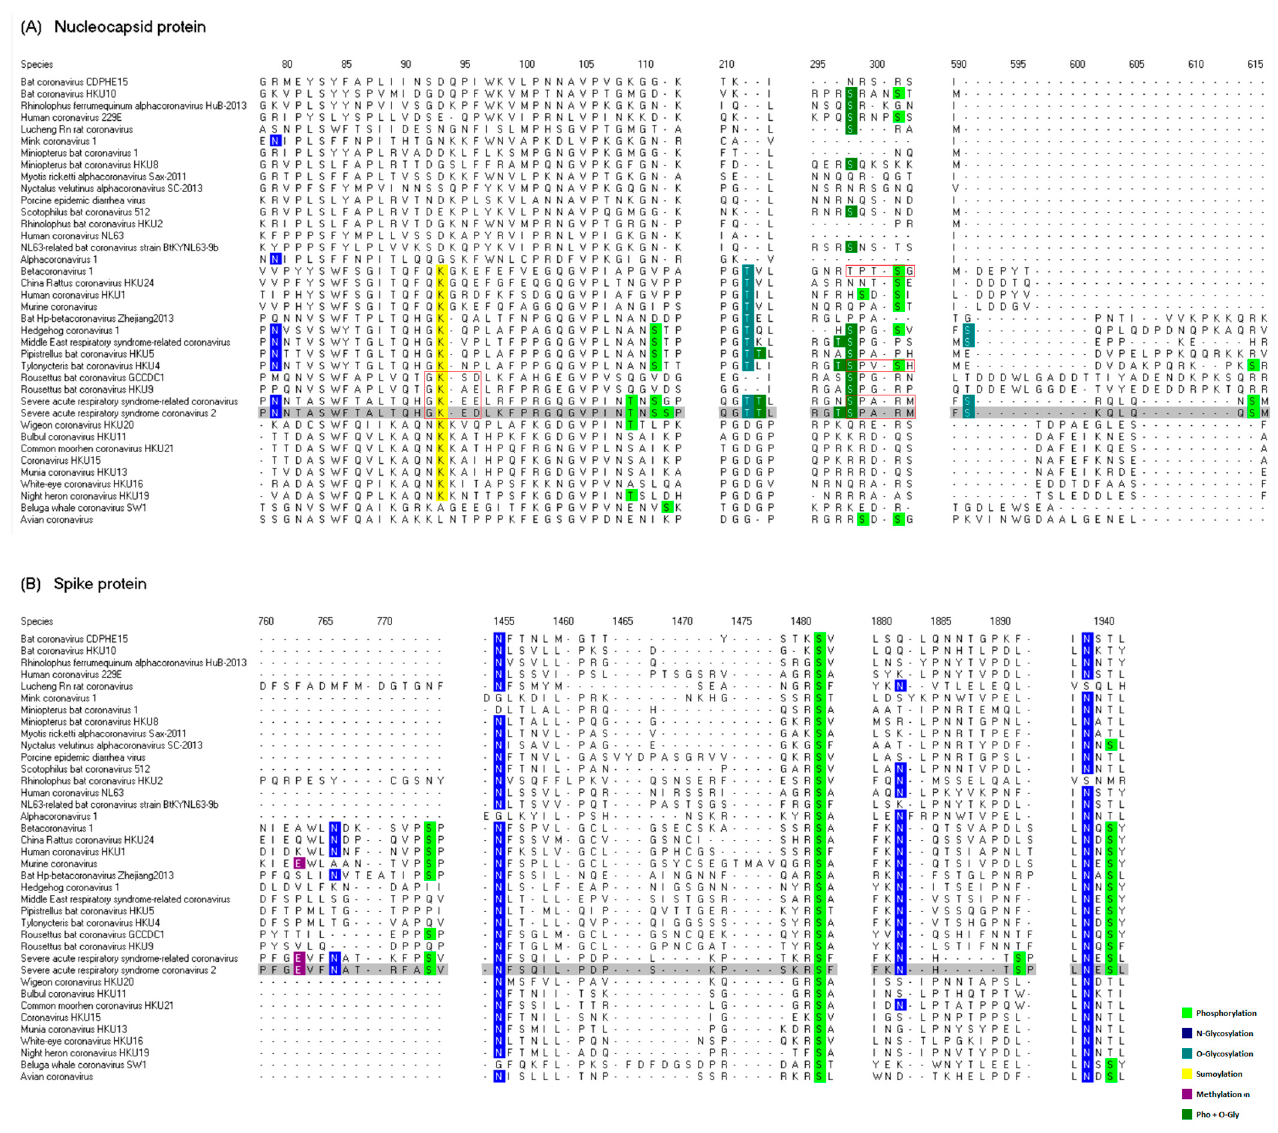
Figure 4. Crosstalk signals in the nucleocapsid and spike proteins. Eight regions of interest in the multiple sequence alignments of ( A ) Nucleocapsid and ( B ) Spike proteins are shown. The numbers at the top correspond to the positions on the alignments. The species names of the 38 coronaviruses are listed on the left side, and the row related to SARS-CoV-2 virus is highlighted in gray. The letters framed in a red rectangle correspond to sequence motifs related to specific PTM types. The PTM sites are represented in different colors as indicated at the bottom right of the Figure.